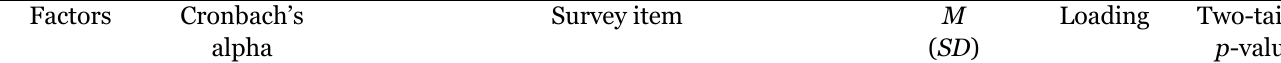
Descriptive Statistics and Model Parameter